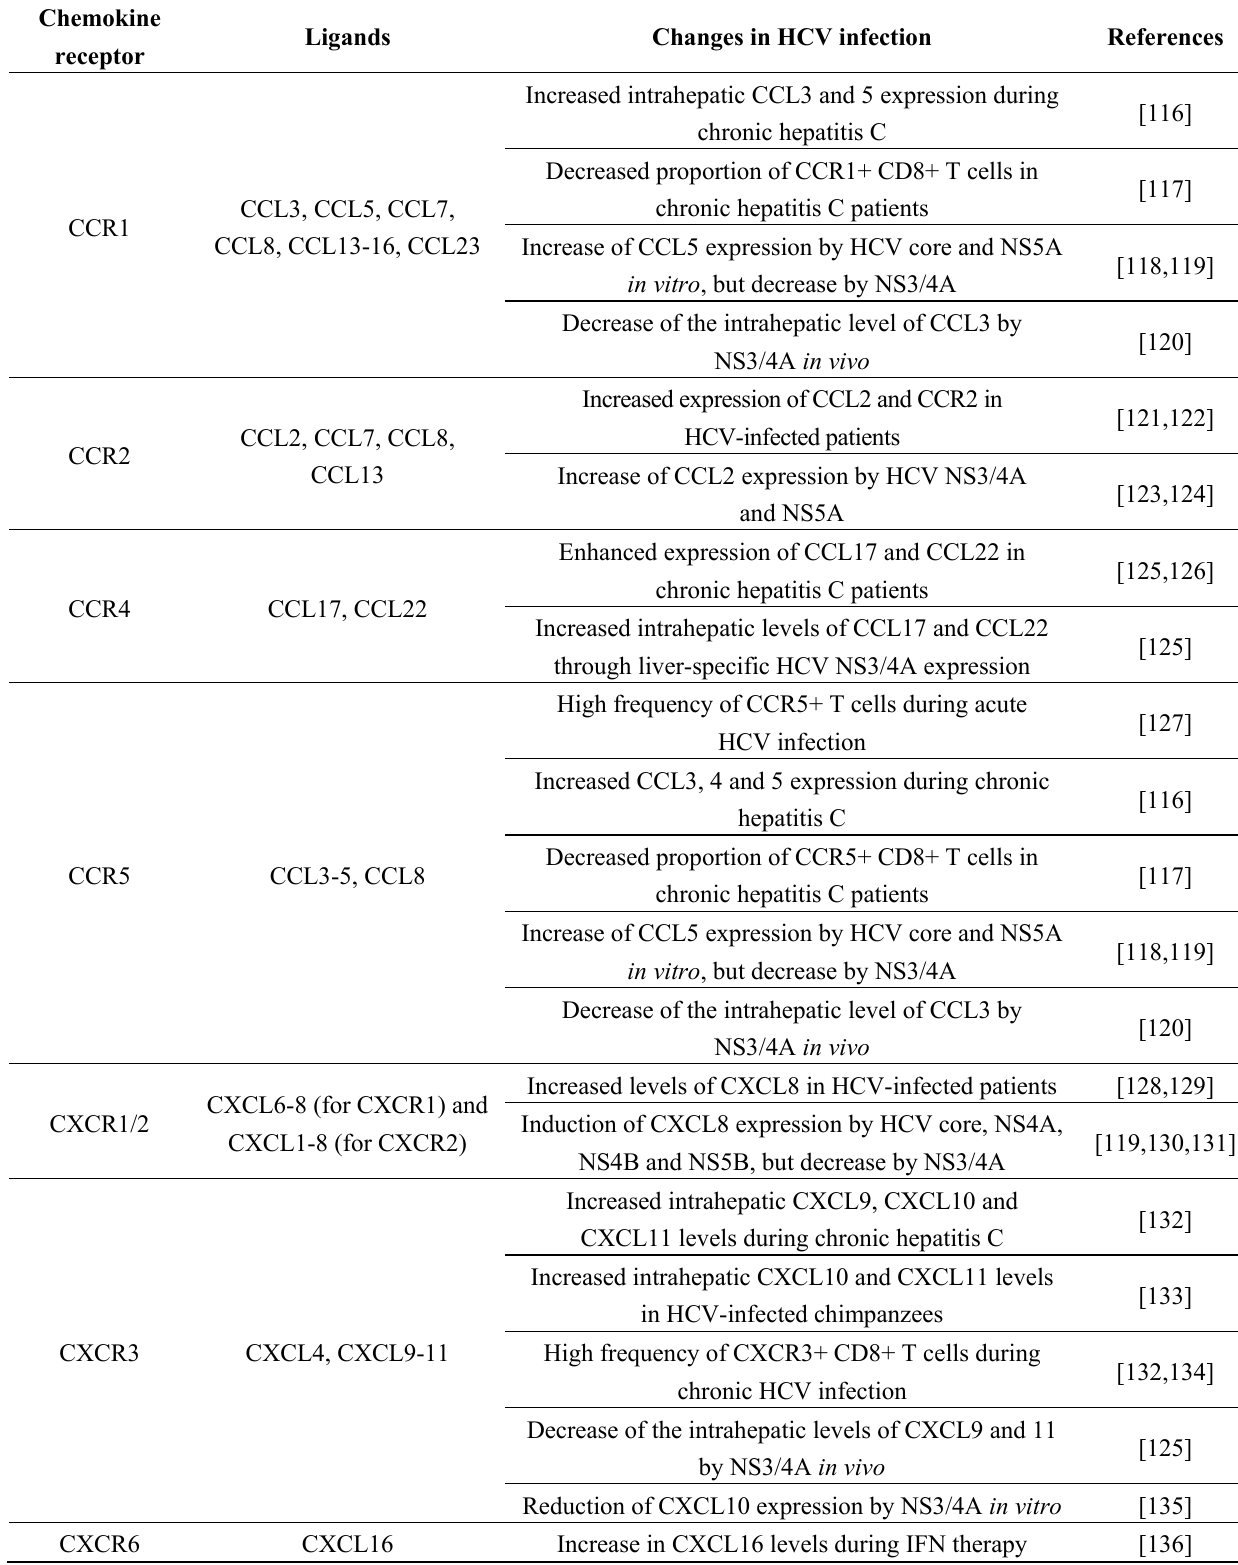
Table 2. Summary of the HCV-mediated changes in the expression of chemokines and chemokine receptors mentioned in this